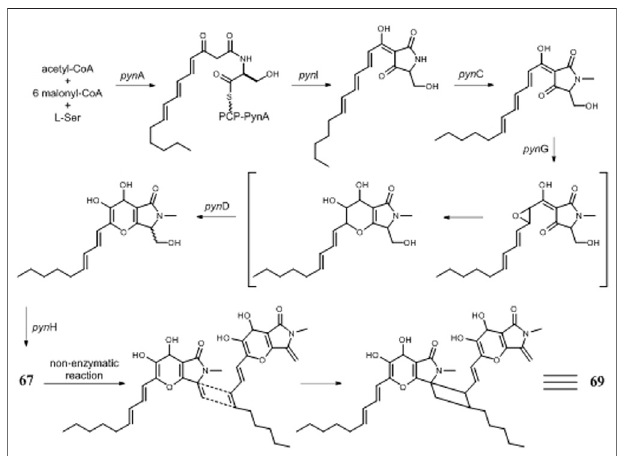
FIGURE 6 | Proposed biosynthetic pathway of pyranonigrin E ( 67 ) and pyranonigrin F ( 69 ).